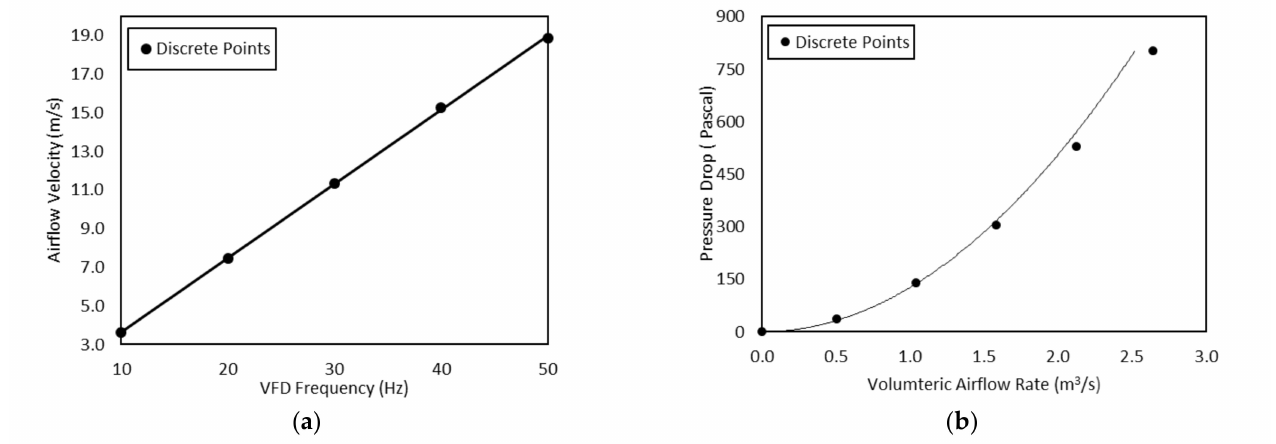
Figure 1. ( a ) Set-up for installation of dust filters for performance testing; ( b ) fibrous dust filter with water spray operational.